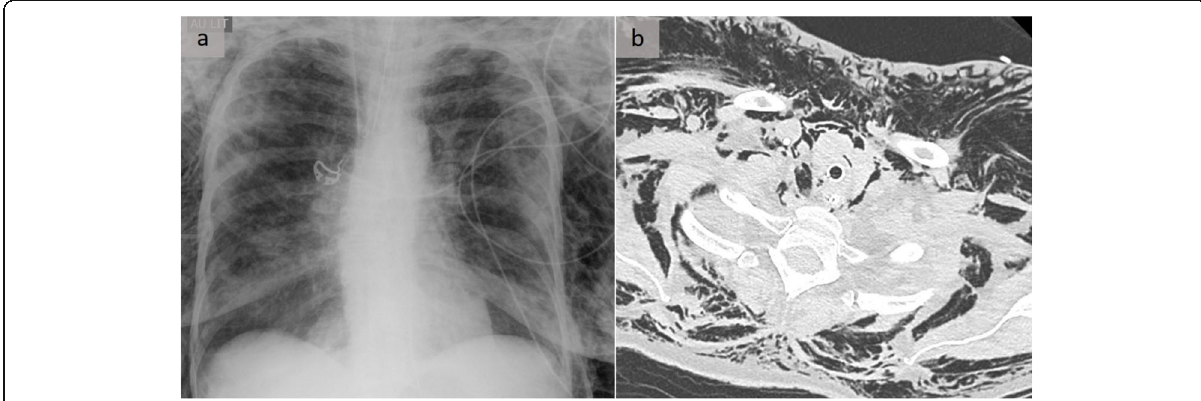
Fig. 3 Pneumomediastinum related to tracheo-esophageal injuries. A patient resuscitated after cardiac arrest with pneumomediastinum related to both tracheal and esophageal injuries. The major finding on the chest X-ray ( a ) was the subcutaneous emphysema. Conversely, the pneumomediastinum is perfectly demonstrated on the axial CT scan ( b